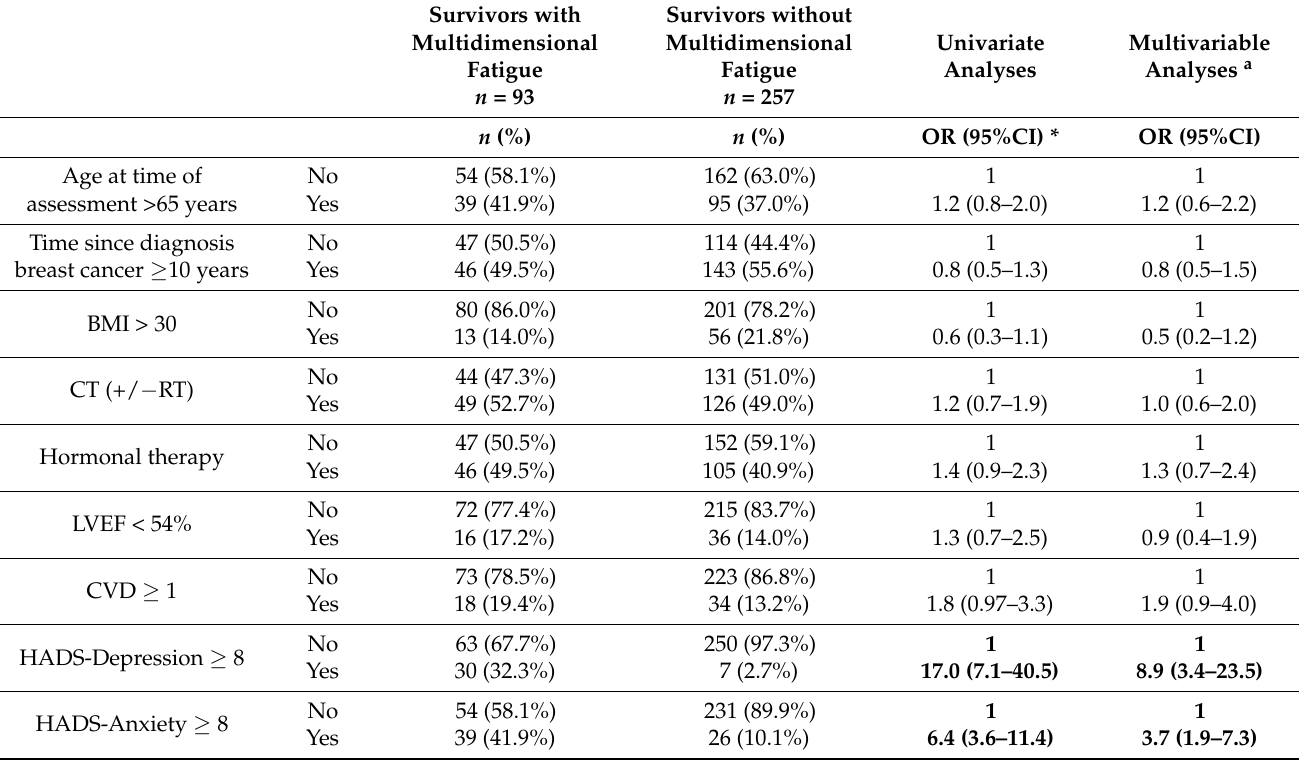
Table 3. Comparison of breast cancer survivors with ( n = 93) and without ( n = 257) multidimensional fatigue